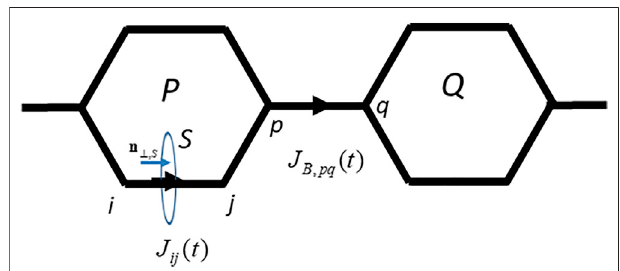
FIGURE 1 | The interatomic bond current J ij ( t ) and bridge bond current J B , pq ( t ) are depicted. Here, i and j indicate the positions of two atomic sites in the bond C i − C j , and each carbon atom C p , or C q belongs to a different aromatic ring P or Q , which are in